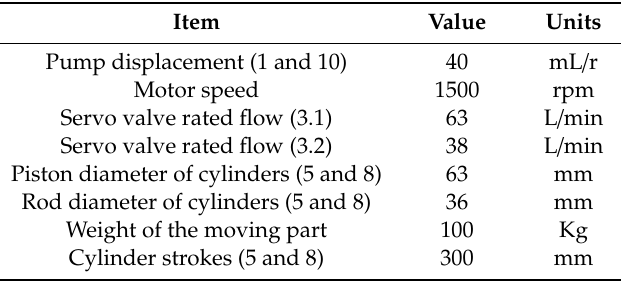
Table 1. Main parameters of the test rig.